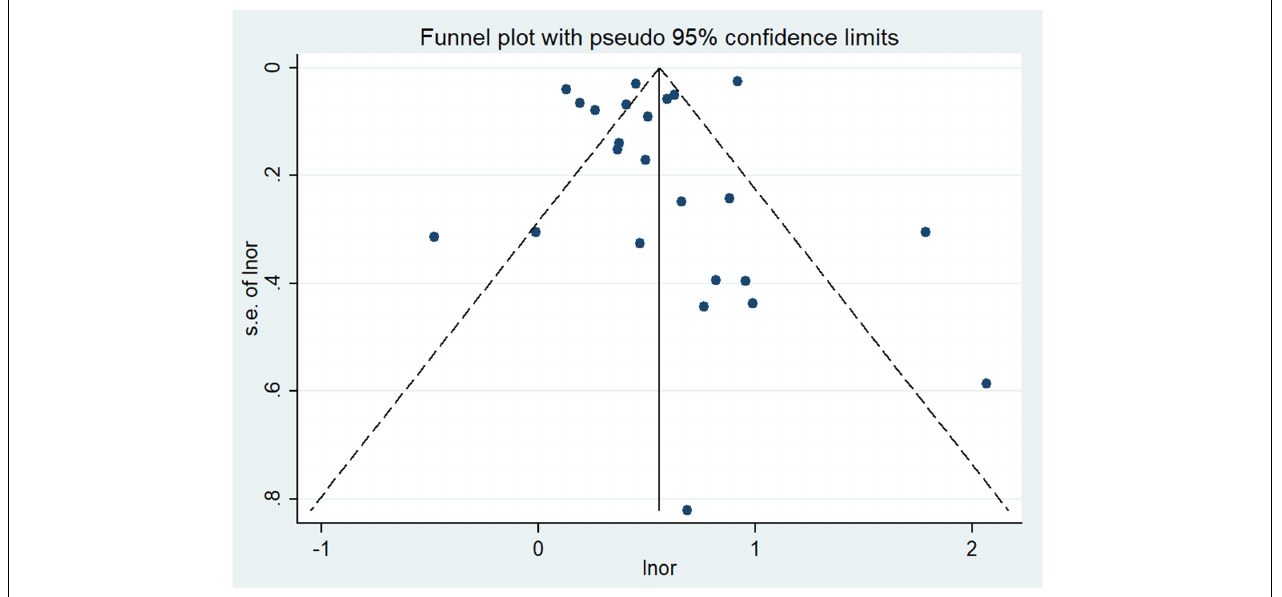
FIGURE 7 | Funnel plot for the association of maternal HDP exposure with risk of overall CHDs in